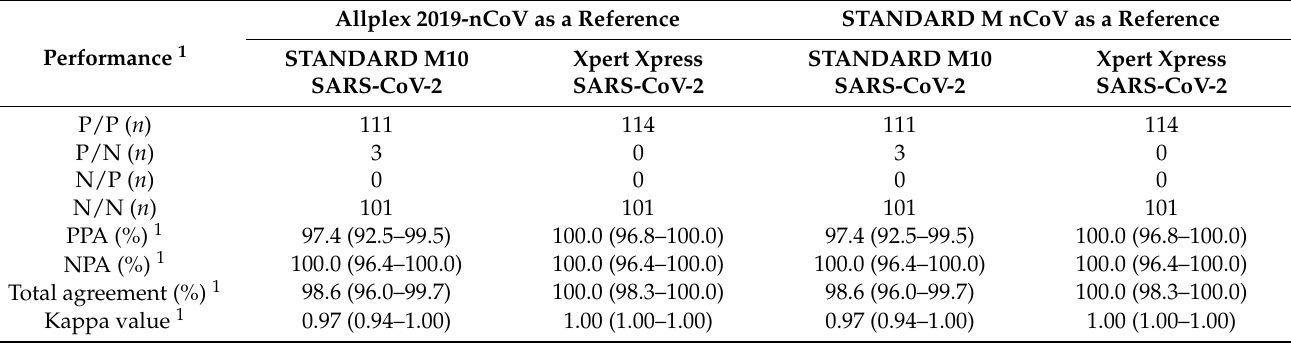
Table 1. Positive percent agreement and negative percent agreement of STANDARD M10